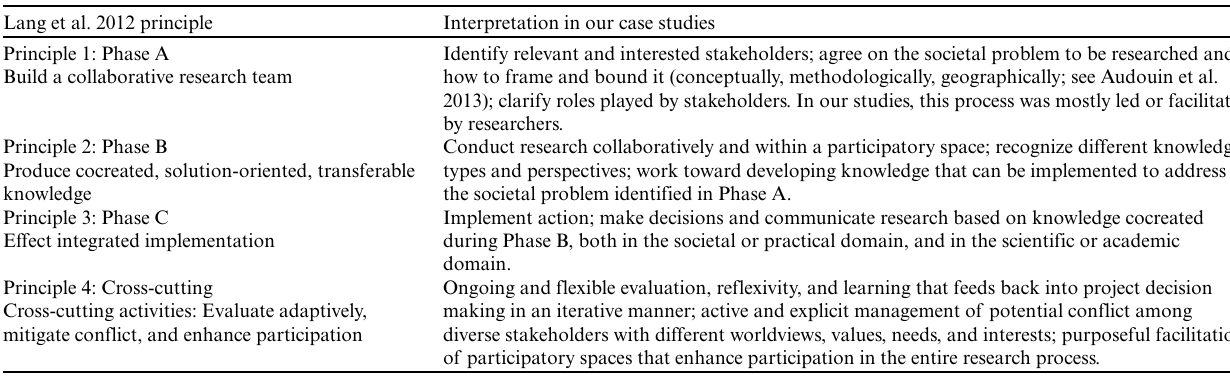
Table 1 . Lang et al. (2012) principles and the interpretation used in the case